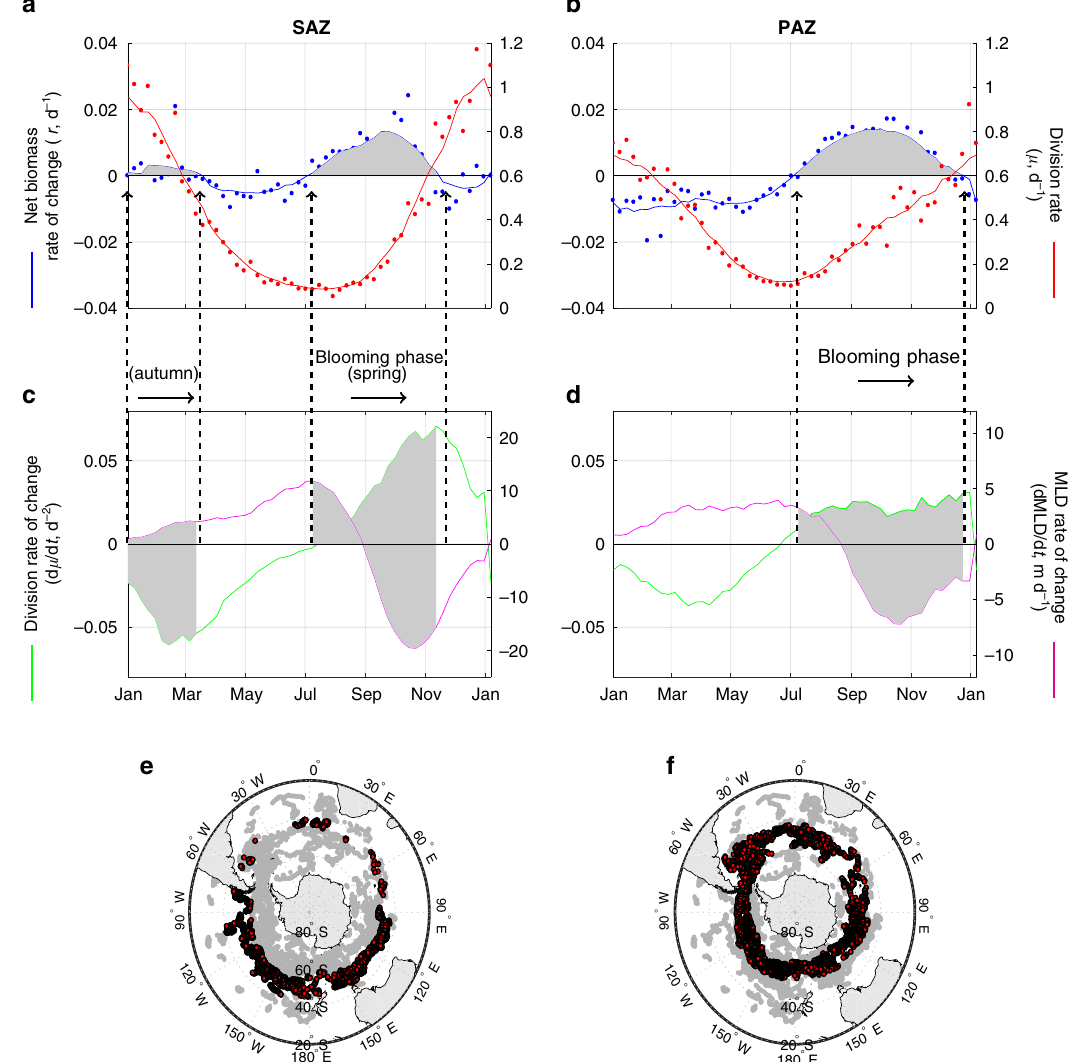
Fig. 2 Climatological bloom cycles in the Subantarctic and Polar Antarctic Zone (SAZ and PAZ). a , b The annual cycle of net phytoplankton biomass rate of change ( r , blue line) and division rates ( μ , red line) for the SAZ and PAZ. Individual points are weekly averaged observations and continuous line is the result of a smoothing temporal fi lter (Methods). c , d Averaged time series of the temporal derivative of μ (d μ /dt, green line) and of the mixed layer depth (MLD) (dMLD/dt, magenta line). The blooming phase ( r > 0) is highlighted by the gray shaded periods. e , f Bottom maps: Location of fl oat pro fi les in the SAZ and